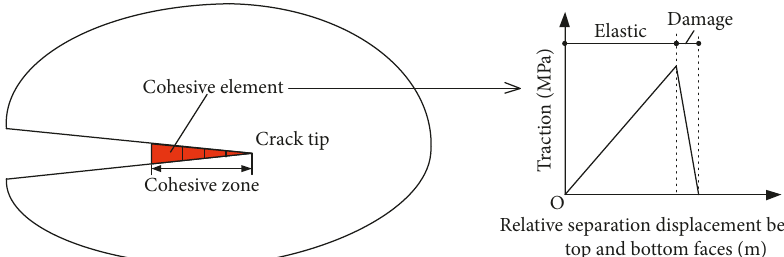
Figure 5: Schematic of the cohesive zone around the crack tip and the traction-separation law for the cohesive